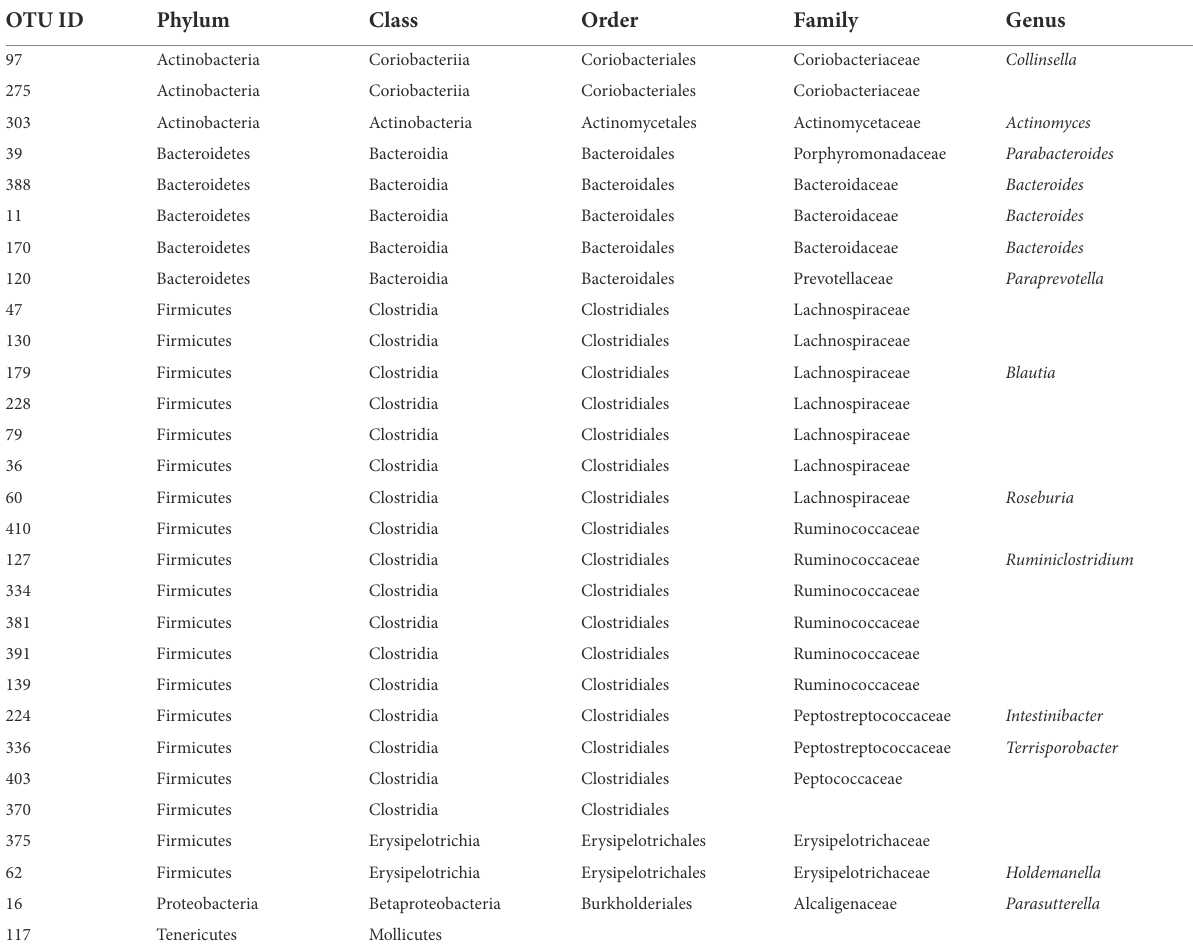
TABLE 2 Summary of the abundance of microbial strains at different species levels between Group M and Group